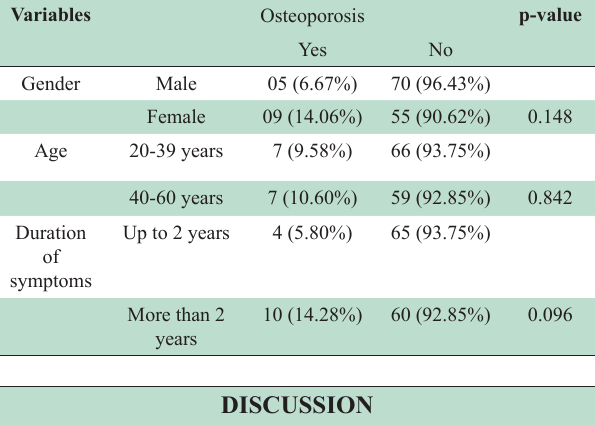
Figure-I: Frequency of osteoporosis (n= 139). Table-II: Osteoporosis and study variables (n=